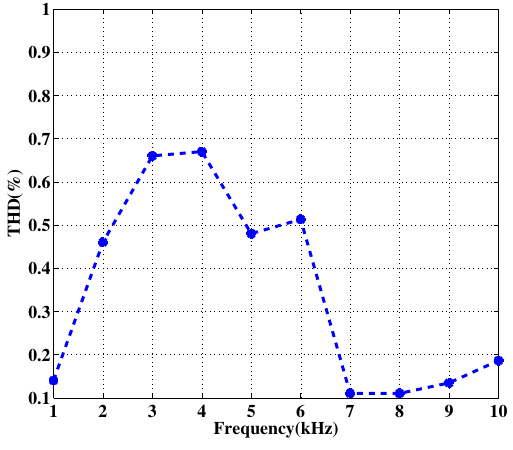
Figure 18. THD (%) at 1